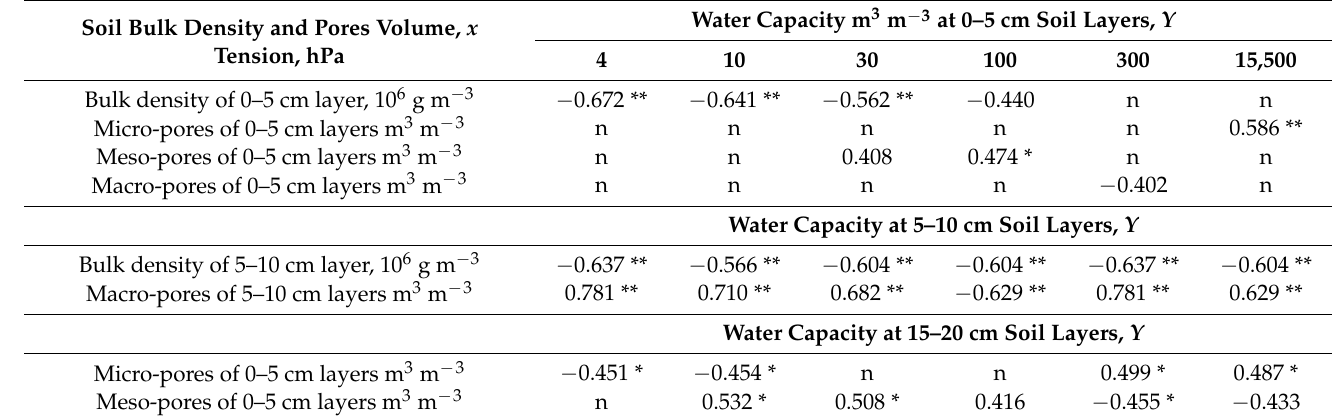
Table 4. Correlation (r) between soil bulk density and volume of pores ( x ) and water capacity ( Y ). Soil Bulk Density and Pores Volume, x Tension,